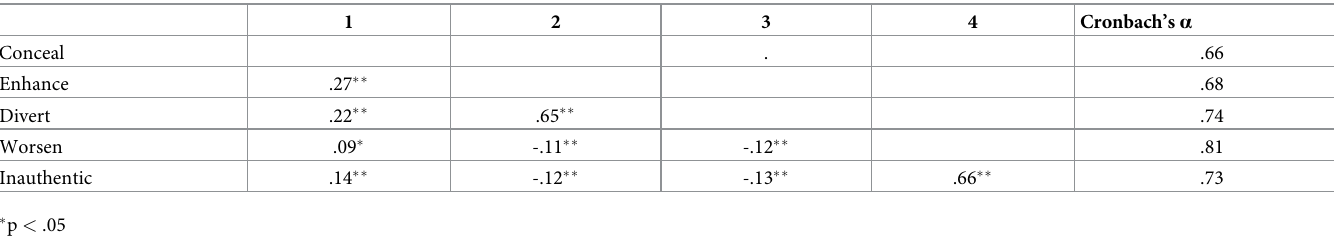
Table 2. Alpha reliabilities and intercorrelations for MEOS-SF factors.